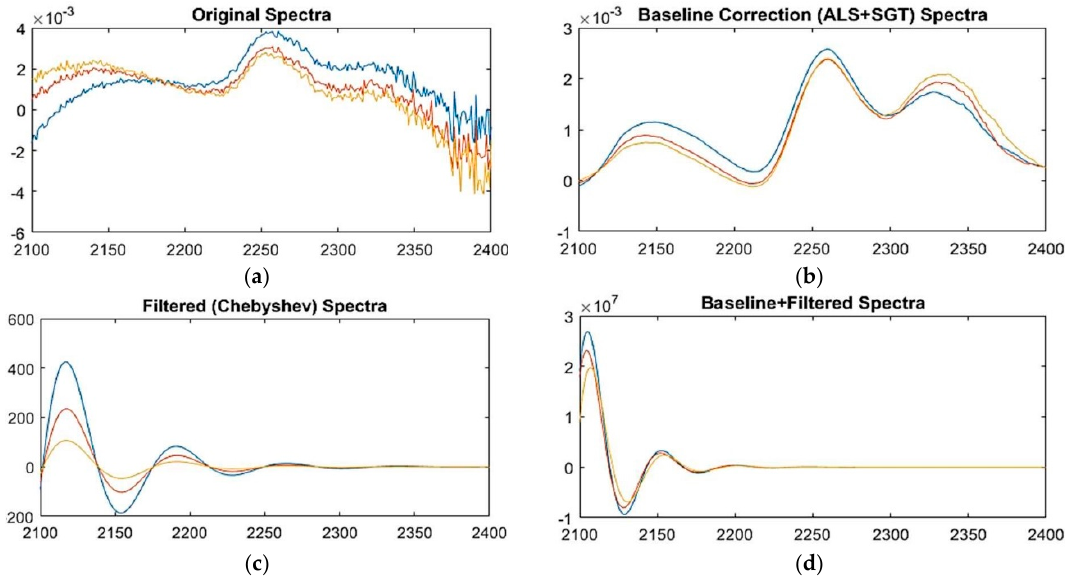
Figure 1. ( a ) Three raw near-infrared spectra of glucose with same concentration ( b ) after baseline (ALS + SGT) correction ( c ) after filtered through Chebyshev ( d ) after baseline correction and filtered.